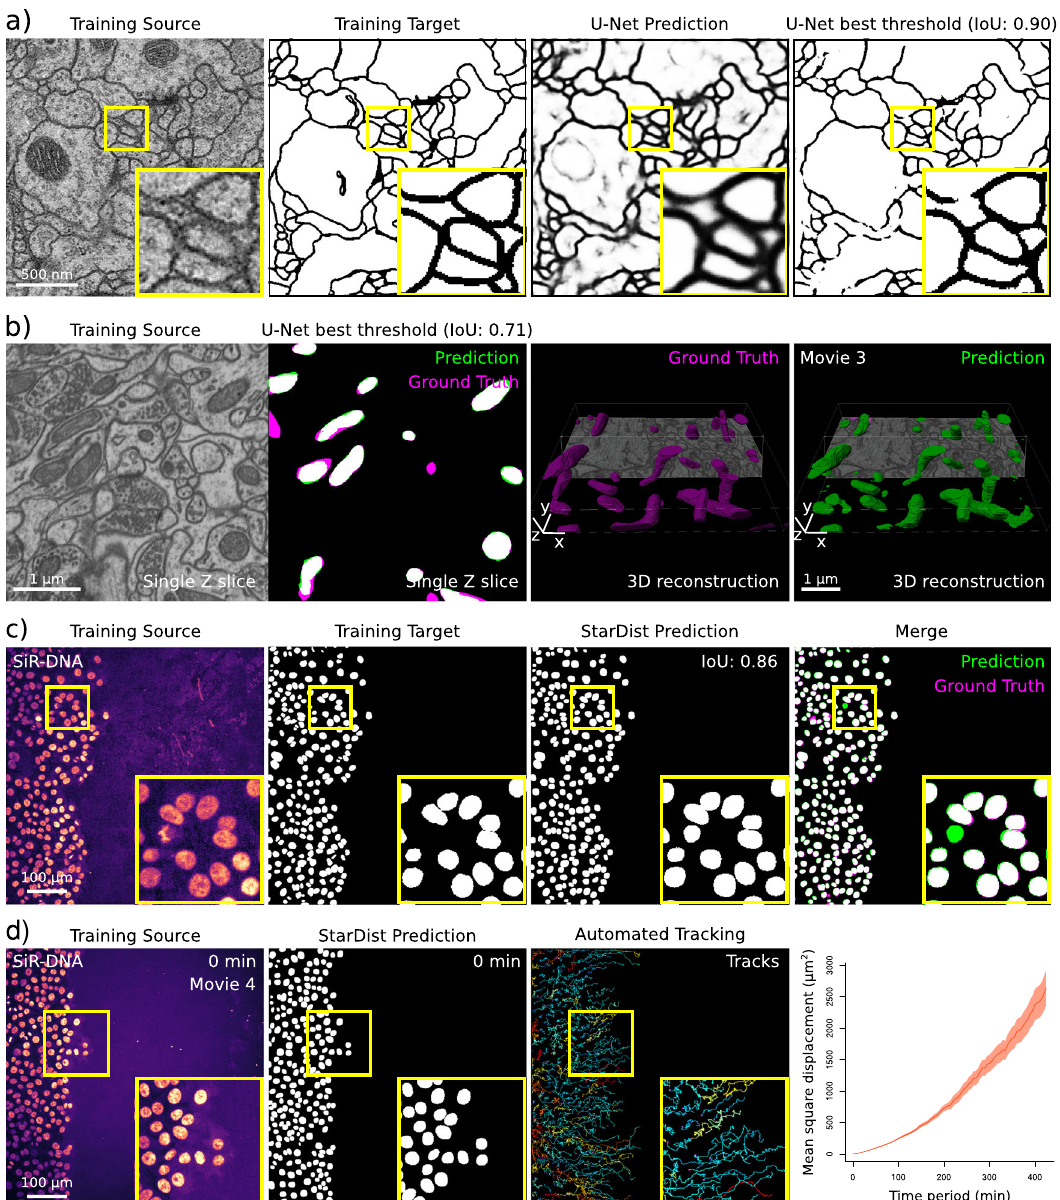
Fig. 2 Image-segmentation networks (U-Net and StarDist). a , b Example of data generated using the ZeroCostDL4Mic U-Net and StarDist notebooks. a A 2D U-Net model was trained to segment neuronal membranes from EM images. This training dataset is from the 2012 ISBI segmentation challenge 78 . Training source (raw data), training targets (hand-annotated binary masks), predictions (raw output of the notebook after training) and U-Net image thresholded output are displayed, achieving an Intersection over Union (IoU) of 0.90 (see Supplementary Note 2 for details). The optimal threshold was assessed automatically using the Quality Control section of the notebook (see Supplementary Note 3). b A 3D U-Net network was trained to segment mitochondria from EM images. The training dataset was made available by EPFL and consists of EM images of 5 × 5 × 5 µ m 3 sections taken from the CA1 hippocampus region of the brain. A representative single Z slice, as well as an overlay displaying U-Net prediction and the ground truth, are displayed. 3D reconstructions displayed were performed from U-Net predictions using Imaris (Supplementary Movie 3). c , d Example of data generated using the ZeroCostDL4Mic StarDist notebooks. c , d A StarDist model was trained ( c ) to automatically detect nuclei in movies of migrating DCIS.COM cells, labelled with SiR-DNA, to track their movement automatically ( d ). c Example of Training source (DCIS.COM cells labelled with SiR-DNA), Training targets (Ground-truth masks) and StarDist prediction (IoU of 0.86) are displayed. d StarDist outputs were used to automatically track cell movement over time in TrackMate (Supplementary Movie 4). Cell tracks were further analysed using the online platform motilitylab.net, indicating a directed movement that is expected for such migration assays (error bars represent the standard deviation). IoU Intersection over